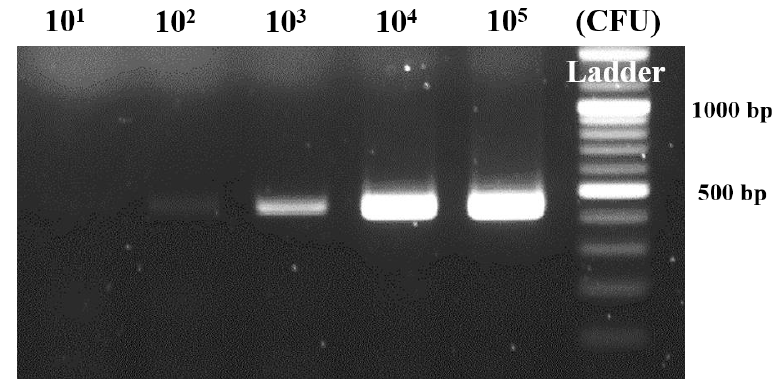
Figure 5. Milk-based Bacillus cereus gene amplification using the optimized condition with film PCR chip. The 1.0 × 10 1 to 1.0 × 10 5 CFU mL − 1 Bacillus cereus was spiked and serially diluted in the milk.